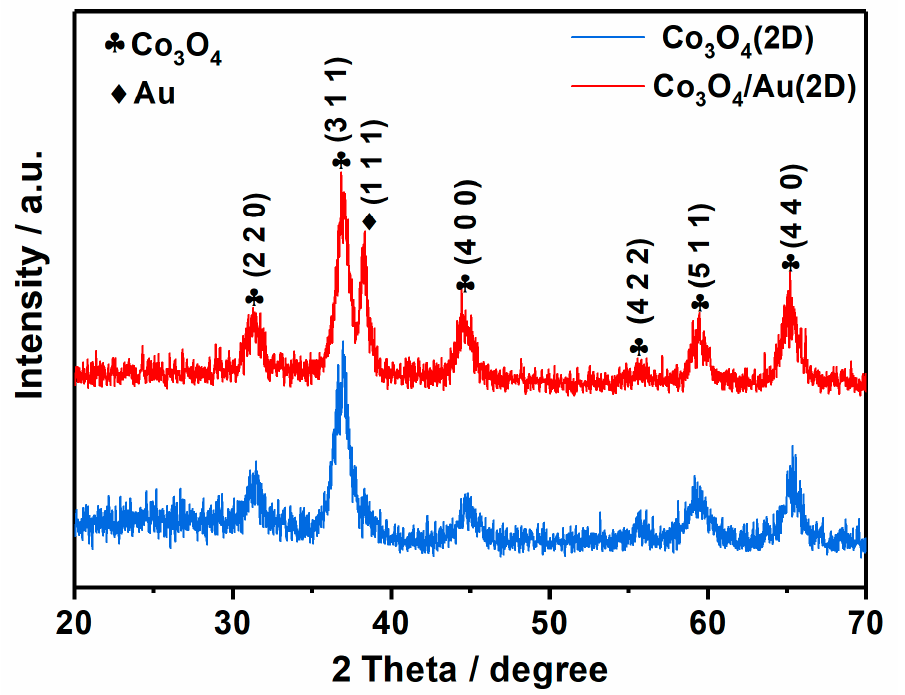
Figure 1. XRD patterns of Co 3 O 4 nanosheets and Co 3 O 4 /Au nanocomposites. The as-prepared samples are further examined by SEM, TEM, and AFM. The SEM image in Figure 2a shows that the wrinkles and transparent Co 3 O 4 nanosheets are obtained, which have a size of 2–5 µ m. Moreover, the porous structure with a size of ~5 nm is also formed in Co 3 O 4 nanosheets after calcining at 300 ◦ C for 0.5 h (see HRTEM images in S3-5), suggesting the successful synthesis of ultrathin porous Co 3 O 4 nanosheets. HAADF-STEM is also conducted to further affirm the structure of Co 3 O 4 nanosheets (Figure 2b), where the bright points represent Co atoms. The selected area electron diffraction (SAED) analysis shows that the nanosheets could be indexed to the (111) plane of cubic spinel Co 3 O 4 . The nonlinear arrangement of Co atoms in the HAADF image (Figure 2b) suggests the slight lattice distortion in Co 3 O 4 nanosheets due to the ultrathin thickness and porous structure. As shown in Figure 2c,d, the height of nanosheets is measured by AFM, which is approximate 2.6 nm, about three times higher than 0.8 nm, the unit-cell dimension of cubic Co 3 O 4 (JCPDS No. 65-3103). Moreover, the morphology and detailed microstructure of Co 3 O 4 /Au nanocomposites are also investigated by TEM and HRTEM. From Figure 2e, it can be clearly observed that Au nanoparticles (black points) are loaded successfully onto the surface of Co 3 O 4 nanosheets, and the closest lattice fringes of Au (the red circle in Figure 2e) are ~0.23 nm, corresponding to the (111) lattice plane of Au. Further, STEM-EDS elemental mapping is used to characterize the elemental distribution of Co 3 O 4 /Au nanocomposites (Figure 3), and the elemental mapping images of the Co, O, and Au elements (Figure 3b,d) suggest that Au nanoparticles are loaded onto Co 3 O 4 nanosheets